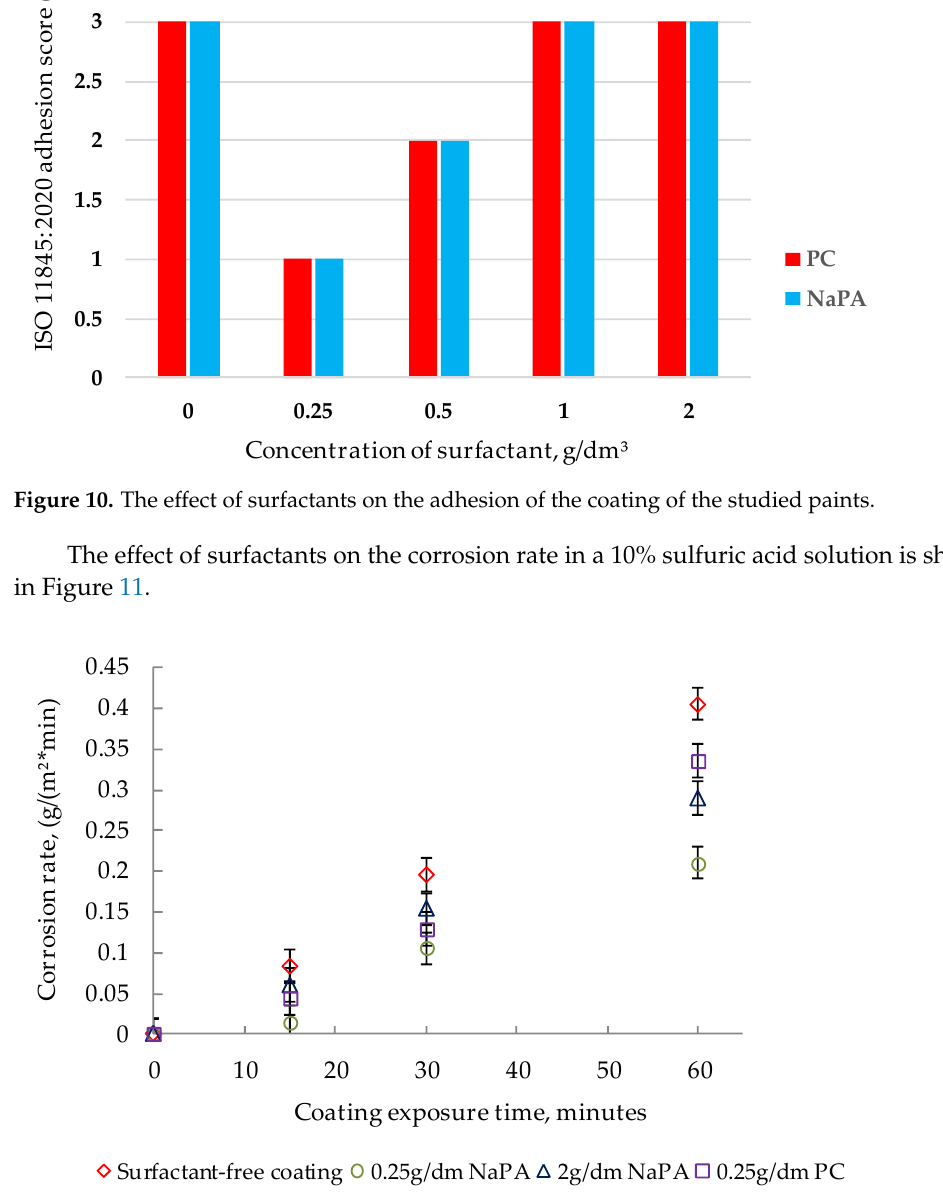
Figure 11. The effect of surfactants on the corrosion rate of the studied paints in 10% sulfuric acid solution.